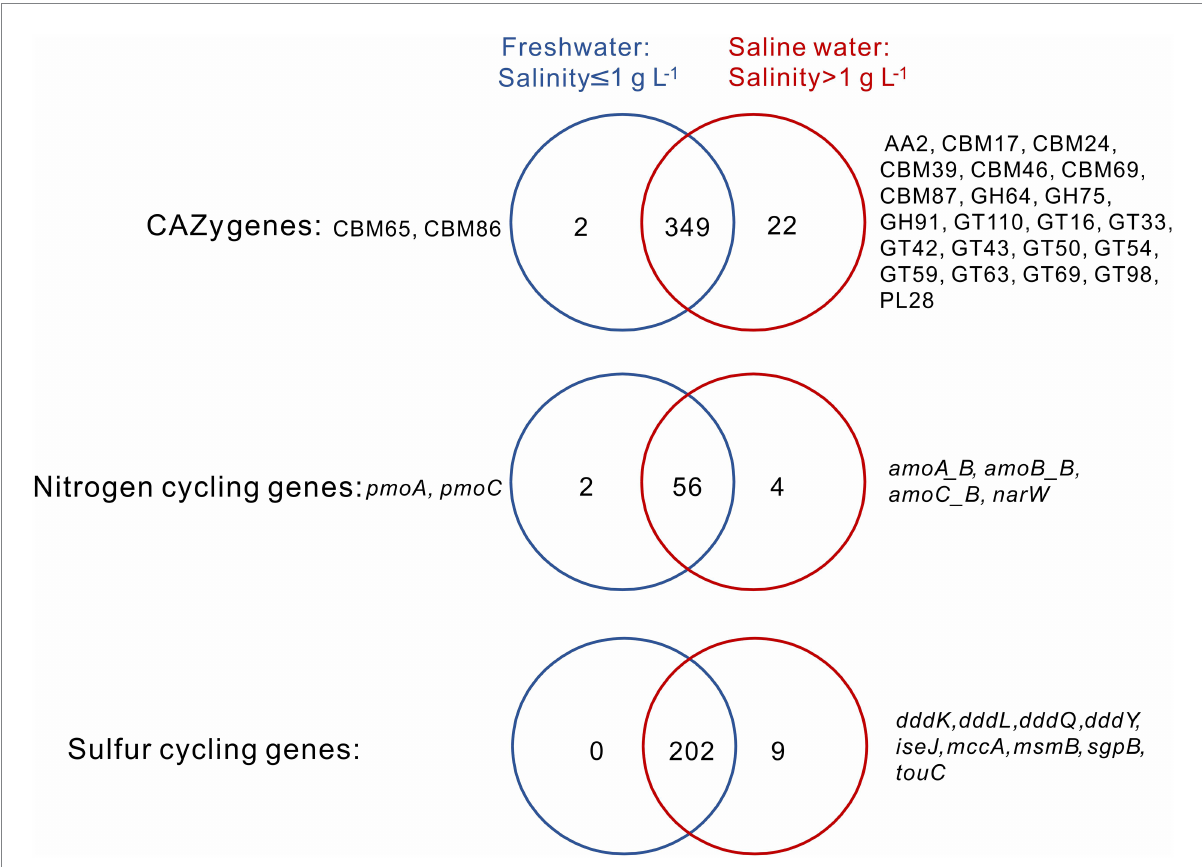
FIGURE 2 Venn diagrams show the numbers of unique and shared CAZy, nitrogen and sulfur cycling genes between the sediment samples from freshwater